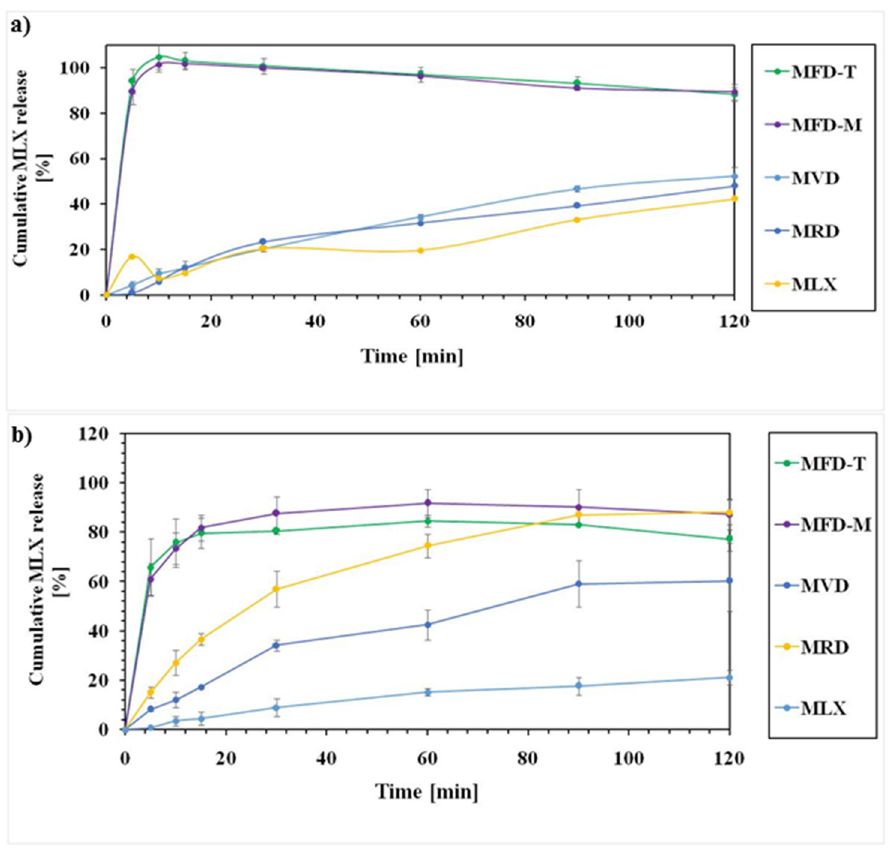
Figure 4 . Dissolution rate of MLX-related samples at PBS of ( a ) 5.6 and ( b ) 7.4. Figure 4. Dissolution rate of MLX-related samples at PBS of ( a ) 5.6 and ( b )